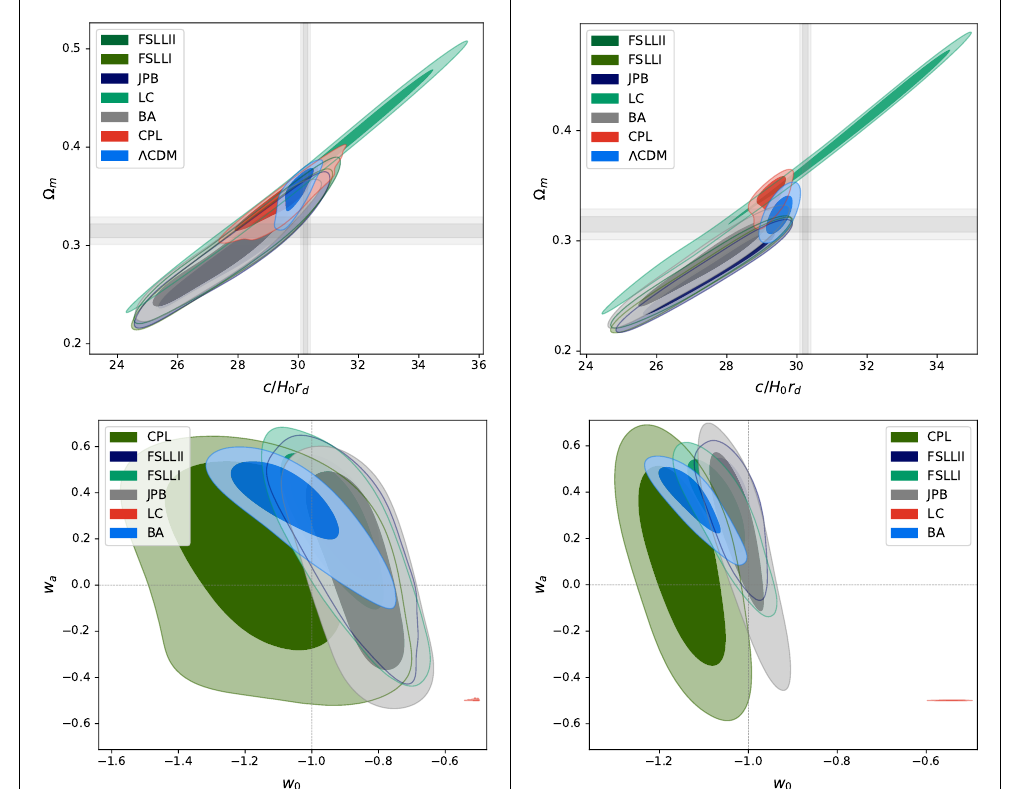
Figure 1. The 2D contour plot for the different DE parametrizations for the BAO+CMB dataset to the left and for the BAO+CMB+SN+GRB to the right. The upper panel shows the results for Ω m vs. c / ( H 0 r d ) and the lower panel shows the results for w and w a . Λ CDM corresponds to w 0 = − 1 and w a = 0. The grey lines show the 1 σ and 2 σ of Ω m and c / ( H 0 r d ) as measured by Planck 2018, while on the bottom plot the gray cross shows where we recover Λ